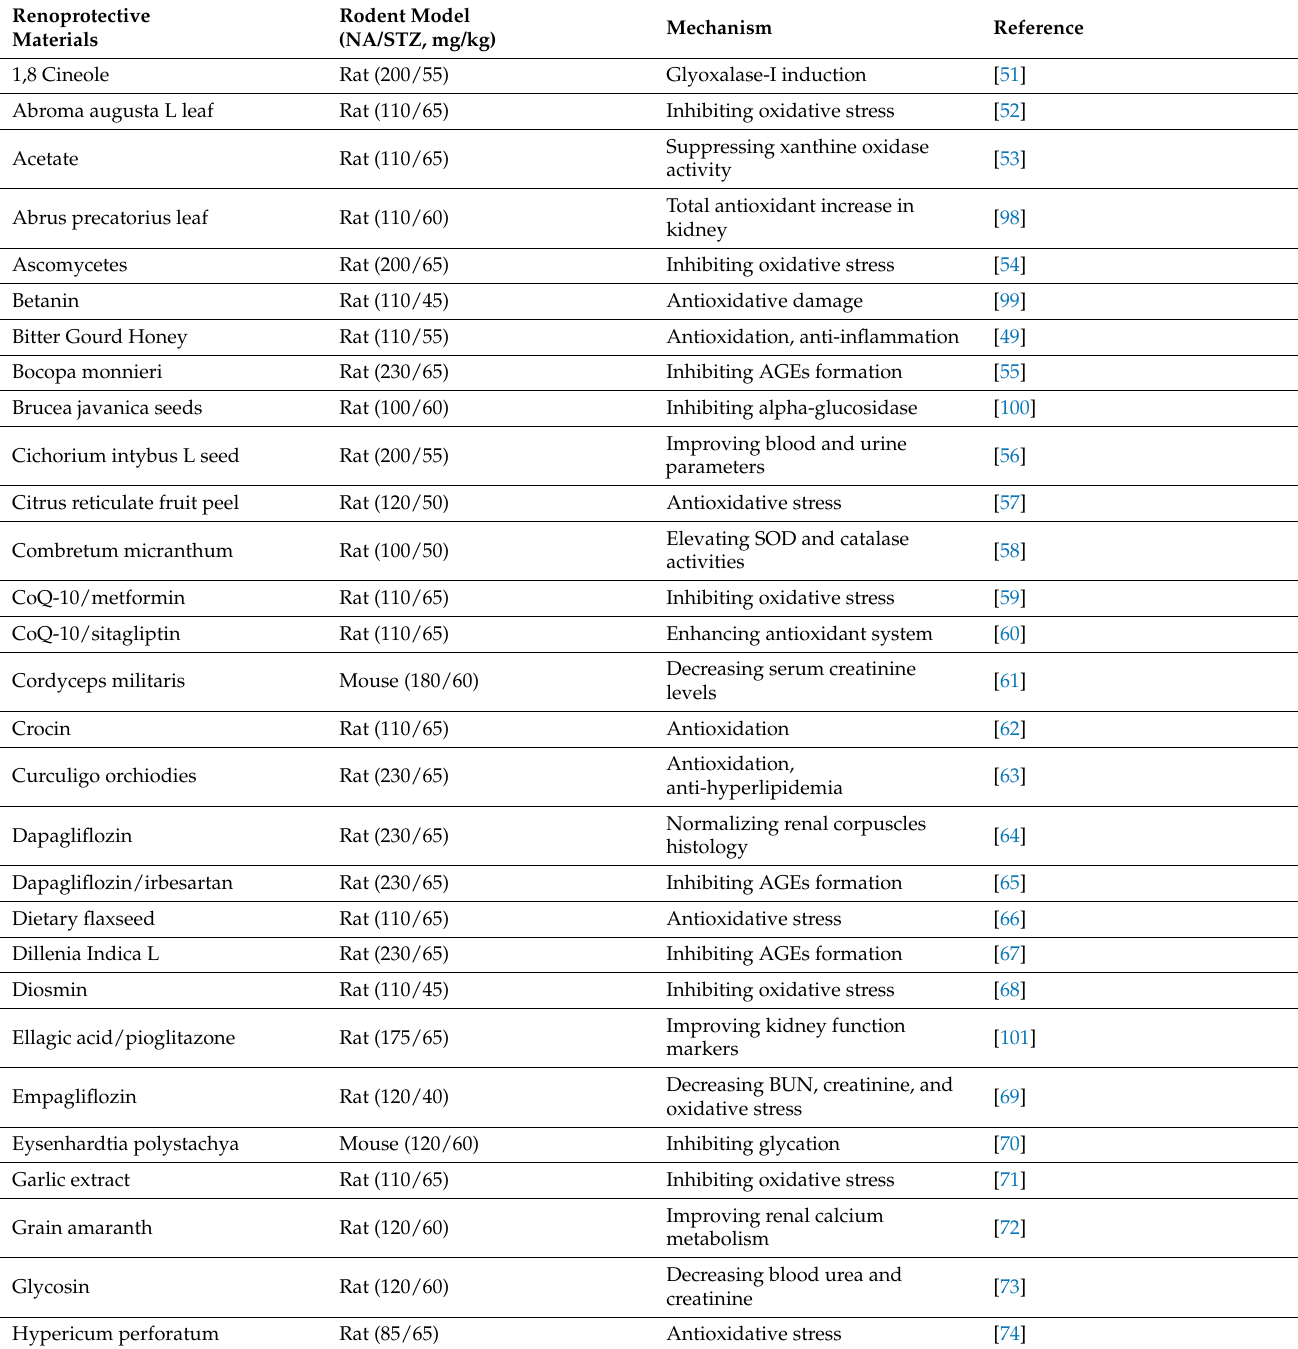
Table 3. Renoprotective materials tested by the NA-STZ type 2 diabetes animal